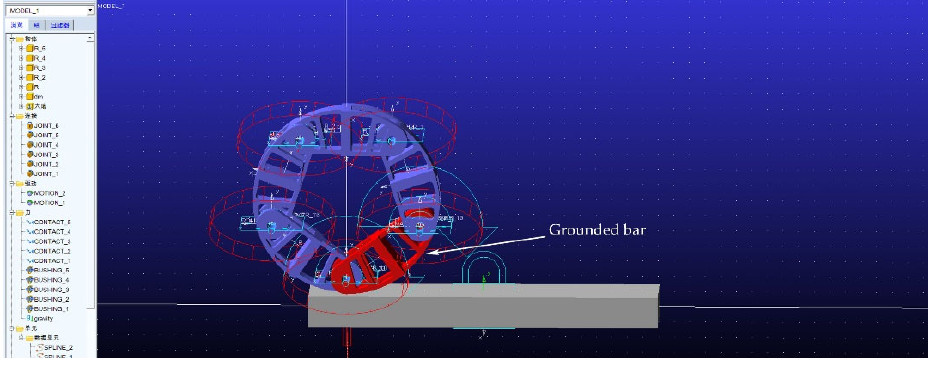
Figure 12. Simulation of ADAMS.